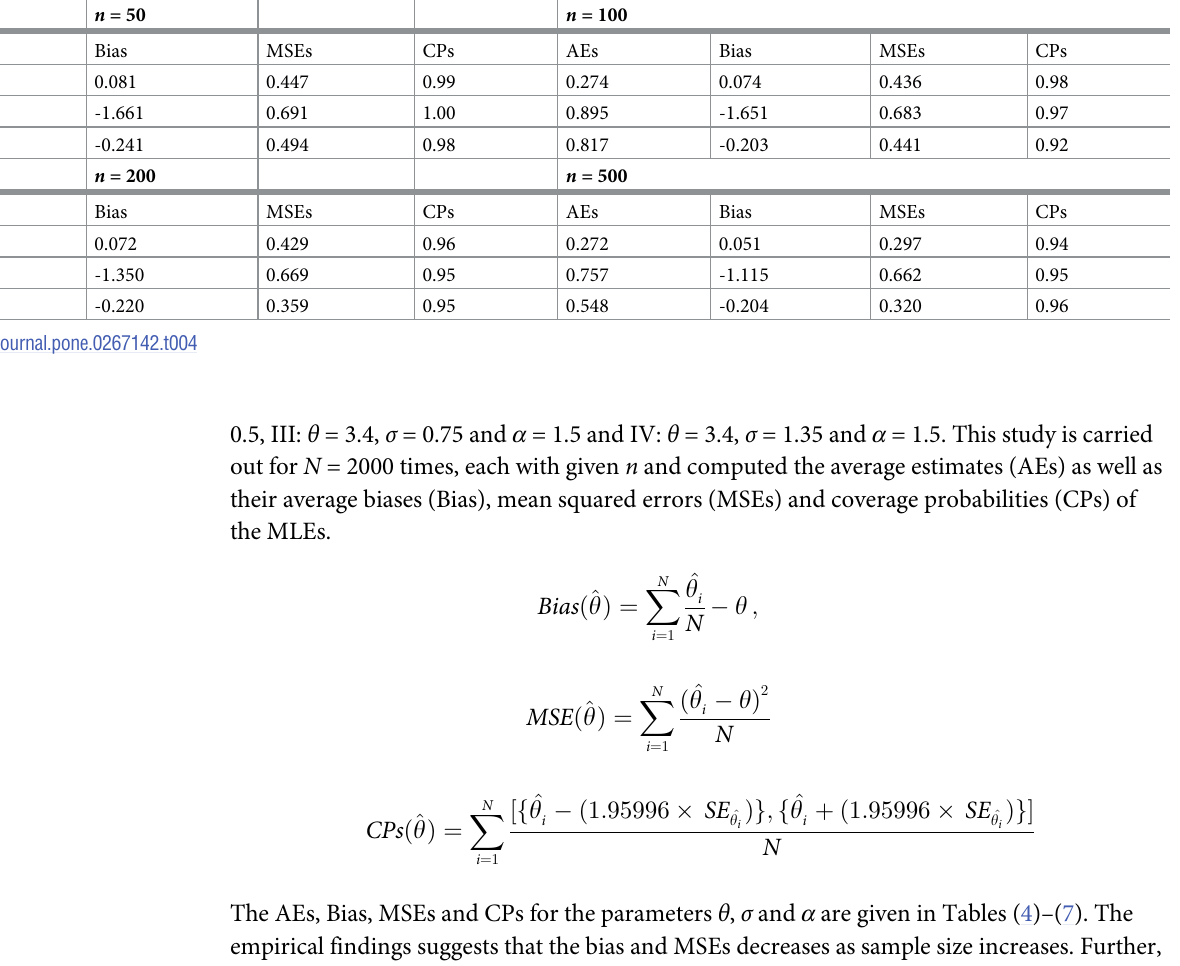
The AEs, Bias, MSEs and CPs for the parameters θ , σ and α are given in Tables (4)–(7). The empirical findings suggests that the bias and MSEs decreases as sample size increases. Further, the empirical CPs are quite close to the nominal level of 95%. As a result, MLEs and their approximate findings can be used to evaluate and build approximated confidence intervals of the EGuNH distribution parameters θ , σ and α .